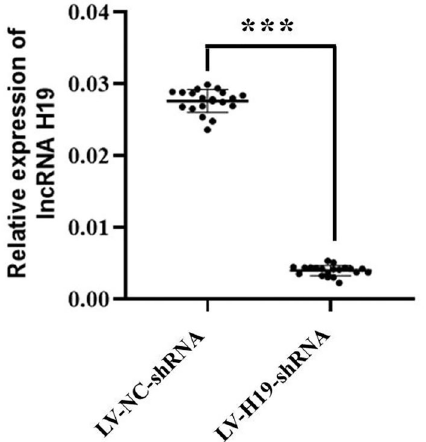
Figure 4. The expression of lncRNA H19 in endometriotic implants was assessed by RT-PCR. Horizontal lines indicate means ± SD. ***P o 0.001 compared to LV-NC-shRNA (negative control) (Student ’ s t